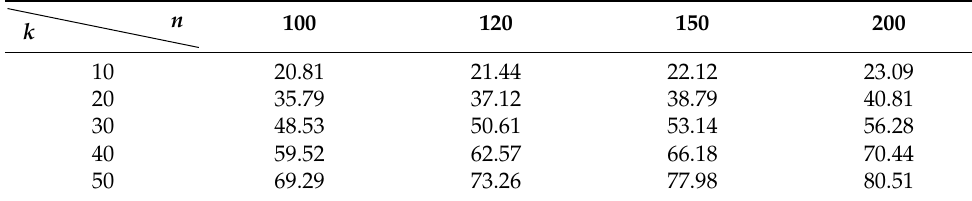
Table 2. The critical values of T k in the case of m = 5 and significance level α = 0.05. n k